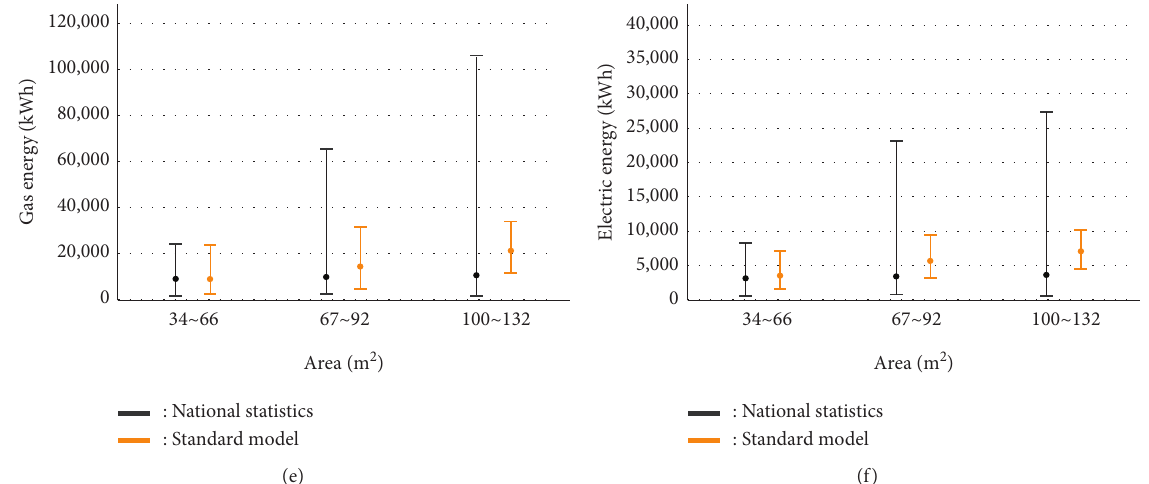
Figure 12: Comparative analysis of energy usage range by building variables (National statistics-Standard model). (a) Gas energy: type of building. (b) Electric energy: type of building. (c) Gas energy: year of completion. (d) Electric energy: year of completion. (e) Gas energy: area. (f) Electric energy: area.